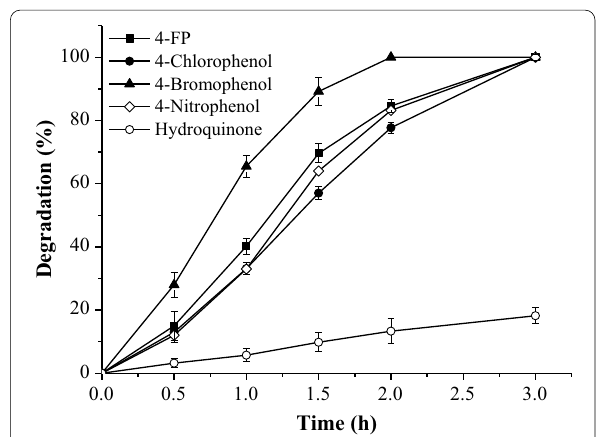
Fig. 6 Degradation of some 4-substituted phenols and hydroquinone by BL- fpd . The data are the mean independent